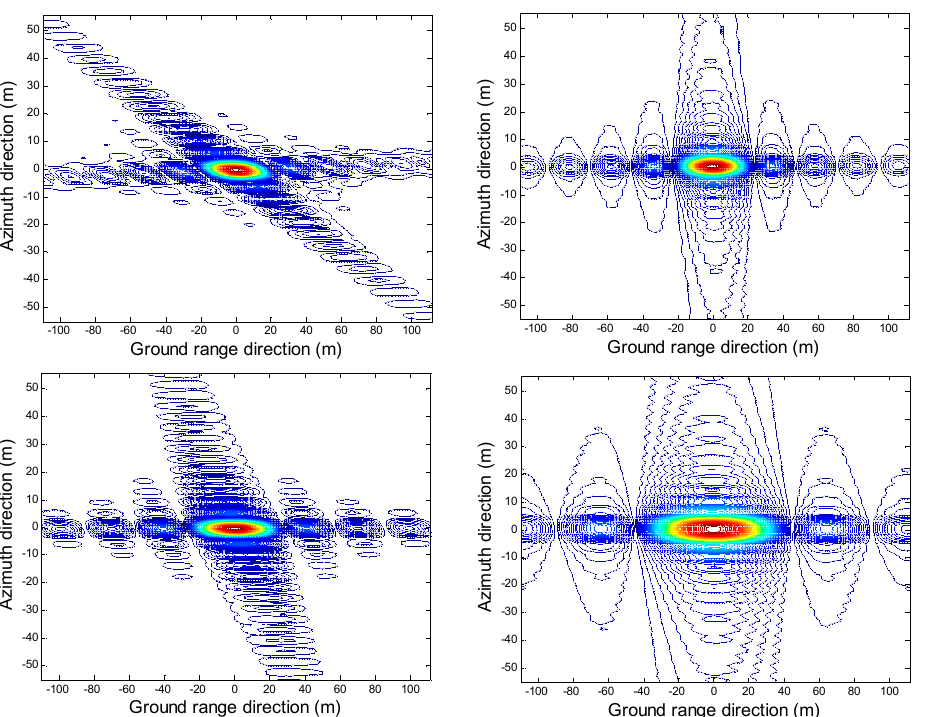
Figure 16. Simulated results of target (0 0 0) in different geometries designed by CPSO.